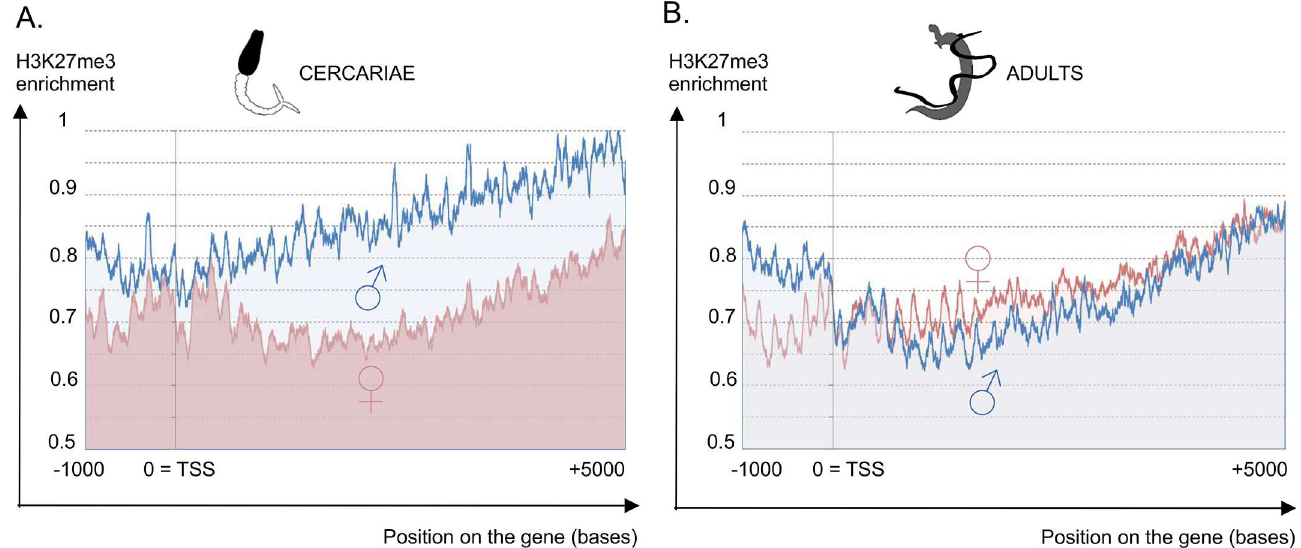
Fig 7. Average H3K27me3 enrichment profile of the chromosome 1 genes. X axis represents the position in bases relative to the transcriptional start site (TSS, position 0), Y axis represents the normalizedmean enrichment of reads obtained after a ChIP targeting the H3K27me3mark on (A) cercariae and (B) adults. The EpiChIP enrichment has been calculated around the TSS of the chromosome 1 transcripts obtained in our RNA-Seq experiment. It has been normalizedwith the same mean enrichment of reads obtainedafter a ChIP without antibody. The mean profile for two male biologicalreplicates (blue) and three female biologicalreplicates(red) are represented. The profile for each replicate is providedin S1 supporting information (Slide 8). The same profile was obtained for the ZW linkage group.